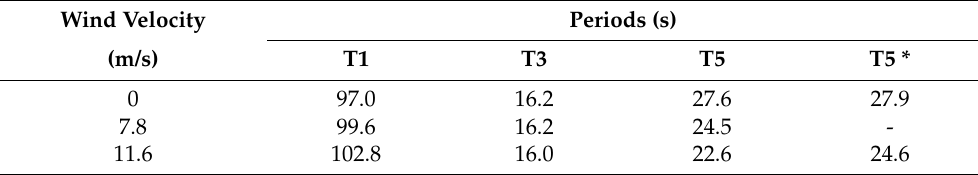
Table 3. Experimental results for surge, heave and pitch natural periods for each wind condition.